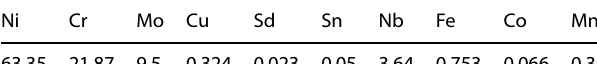
Table 8. The square-shaped Q245R structure steel with a length of 100 mm, a width of 100 mm, and a thickness of 5 mm were used as the substrate. Table 8. Chemical composition of Inconel 625 powder (wt.%).